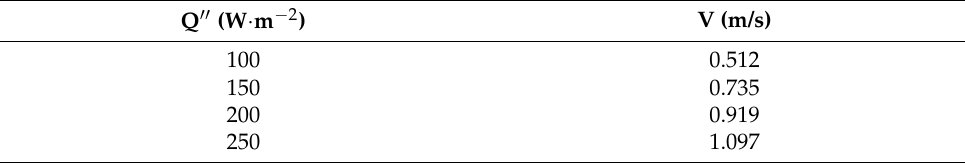
Table 5. Results of BO inverse mapping to estimate velocity to ensure comfort for various